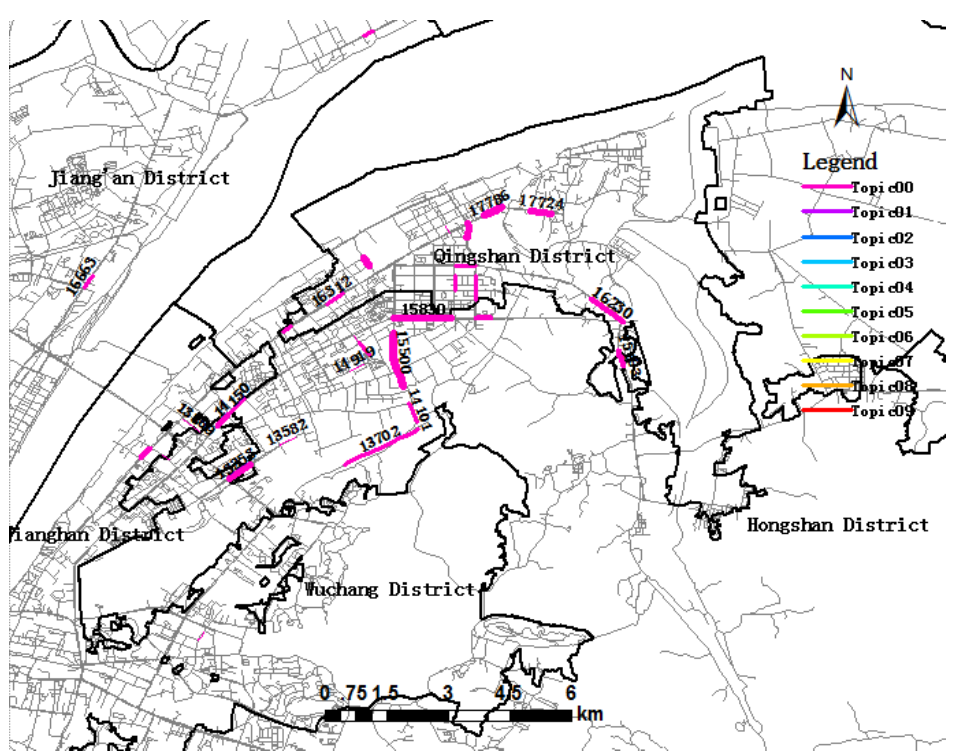
Figure 10. Visualization of trip Topic00 during the morning rush hour period.